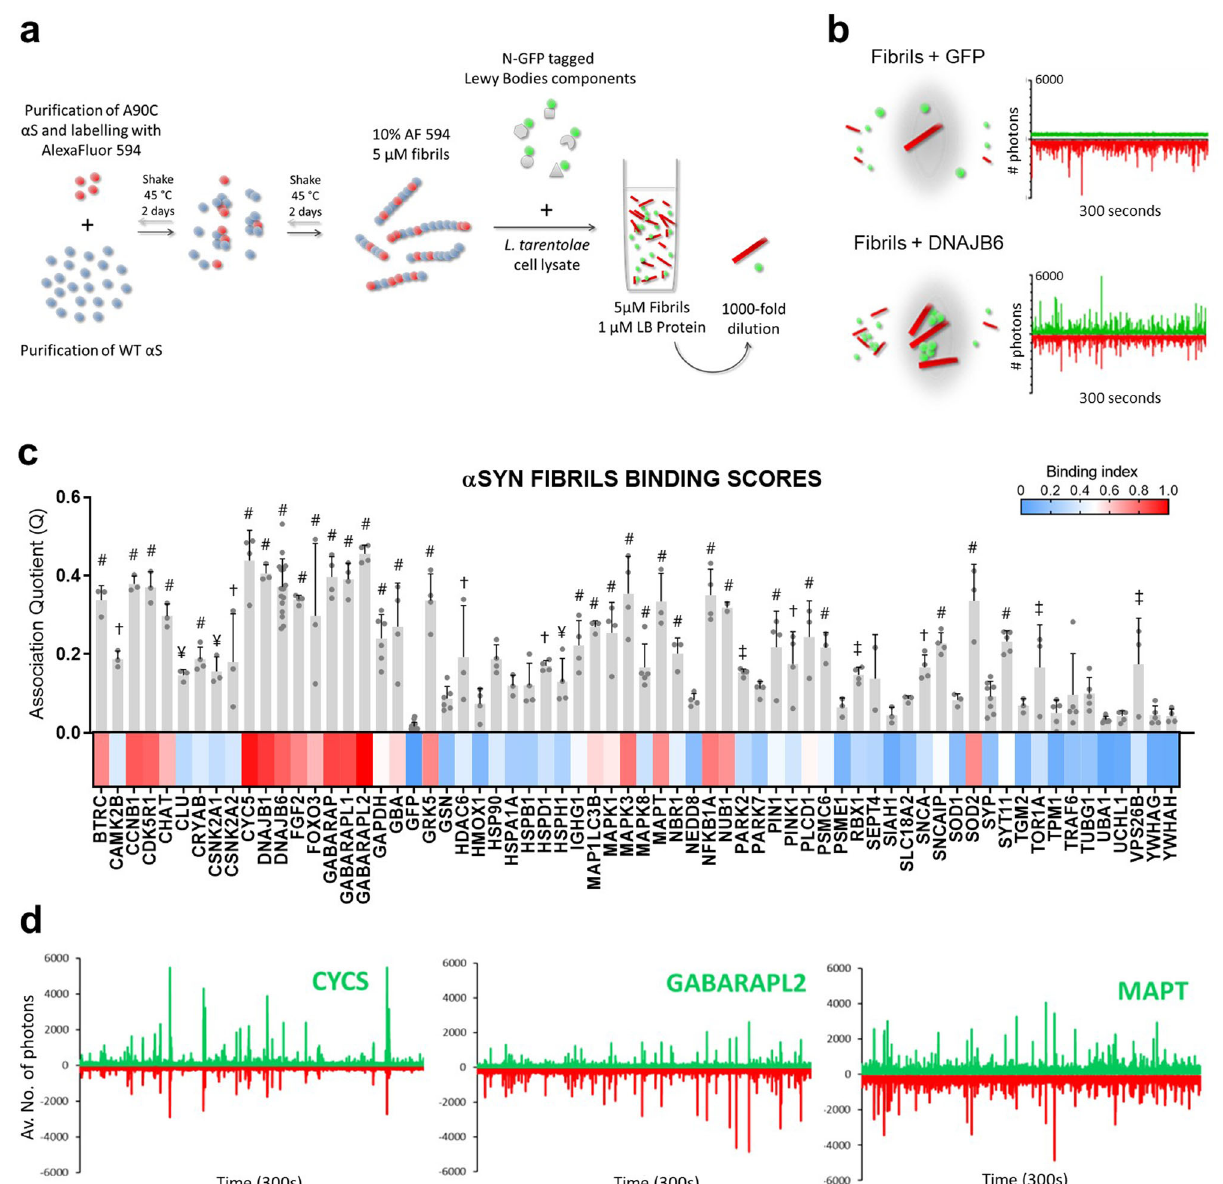
Fig. 5 Interactors of pre-formed fi brils of alpha-synuclein. a Schematic representation of the experimental layout for production of pre-formed α -SYN fi brils. Puri fi ed cysteine mutated α -SYN was labelled with AlexaFluor dye 594 (red spheres) and mixed with puri fi ed WT α -SYN (blue spheres). After shaking at 45 °C, fi brils were primed with the cell-free expression reaction of LTE for all the LB proteins tested. After cell-free expression, the mixture was diluted 1000-fold to reach single particle concentrations for TCCD experiments. b Schematic representation of the confocal volumes during measurements of 300 s traces. GFP monomer served as a negative control and a known interactor of α SYN as a positive control (DNAJB6) for acquisition of Association Quotients. c Bar plot of Q values for all the quadruplicated 300 s traces and normalized heatmap of binding indexes (BI = 0 for GFP monomer and BI = 1 for the highest Q value). Error bars represent mean ± SEM. Dunnett ’ s multiple comparisons test against traces of Fibrils + GFP. # p ≤ 0.0001, † p ≤ 0.001, ‡ p ≤ 0.01, ¥ p ≤ 0.05. d Traces of three of the main interactors, as de fi ned by the top percentile in the distribution of Q values. For all traces in this fi gure, GFP signal is represented in positive axis, mCherry signal in negative expressed N-mCherry-tagged PINK1 with the library of 65 N- for damaged mitochondria and accumulates at their outer mem- GFP-tagged LB proteins and measured Association Quotients for brane, recruiting Parkin (PARK2), which targets them for degra- all pairwise co-expression, in triplicate. Our data show that the dation through autophagy 16,17 . Mutations in the serine/threonine kinase domain of PINK1 have been found in a number of PD interactome of PINK1 (Fig. 6a) differs signi fi cantly from the patients, where PINK1 fails to protect against stress-induced interactome of a similarly cell-free-expressed synuclein (A53T in mitochondrial dysfunction caused by exacerbated α -SYN Fig. 6b). To understand whether the interactors of α -SYN were aggregation 18,19 . Because PINK1 is genetically implicated in selective, we plotted in two dimension the Association Quotients early-onset PD 19,20 , accumulates in LBs 21 and forms large aggre- for A53T and PINK1. The scatter plot of Fig. 6b shows that the gates when expressed in our cell-free system, we believed that this main interactors of A53T do not bind signi fi cantly to PINK1: would be a good candidate for a selectivity counter-screen. We co- proteins from GABARAP/LC3 subfamilies, CRYAB and A53T